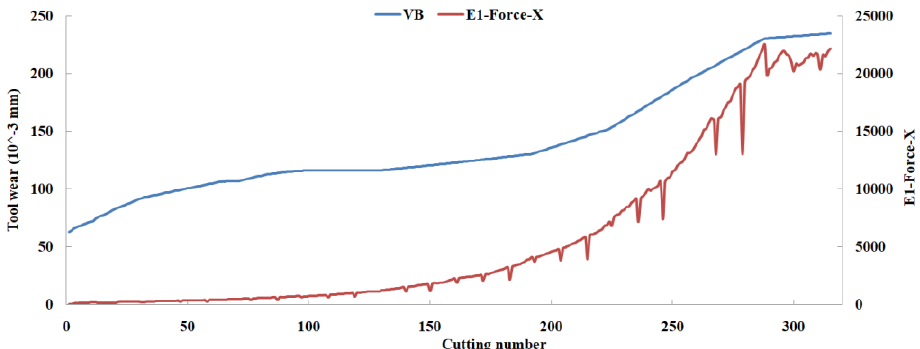
Figure 12. The scatter diagram between E 1 in X-dimension Force and tool wear value.